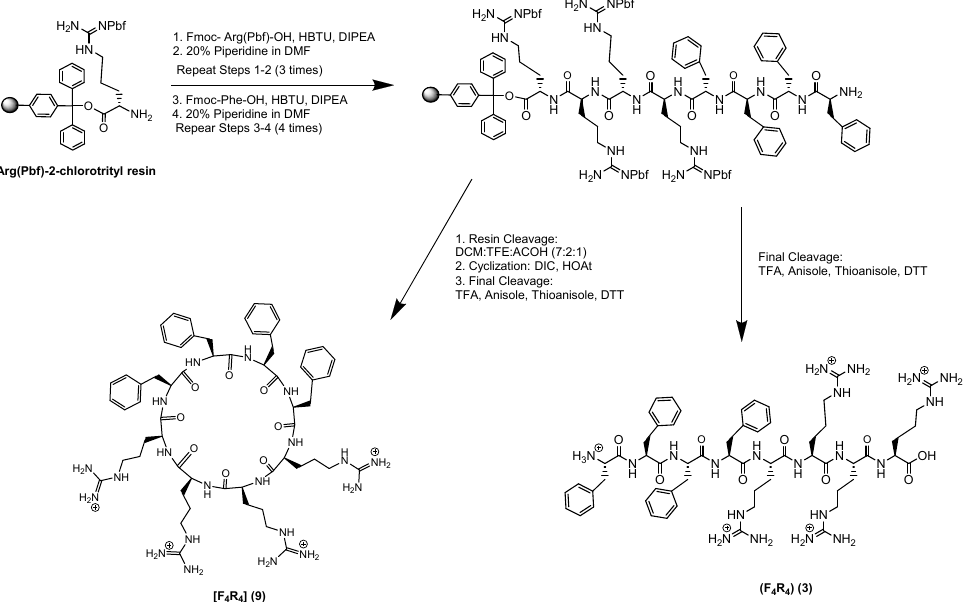
1.ResinCleavage: DCM:TFE:ACOH(7:2:1) 2.Cyclization: DIC,HOAt 3.FinalCleavage: